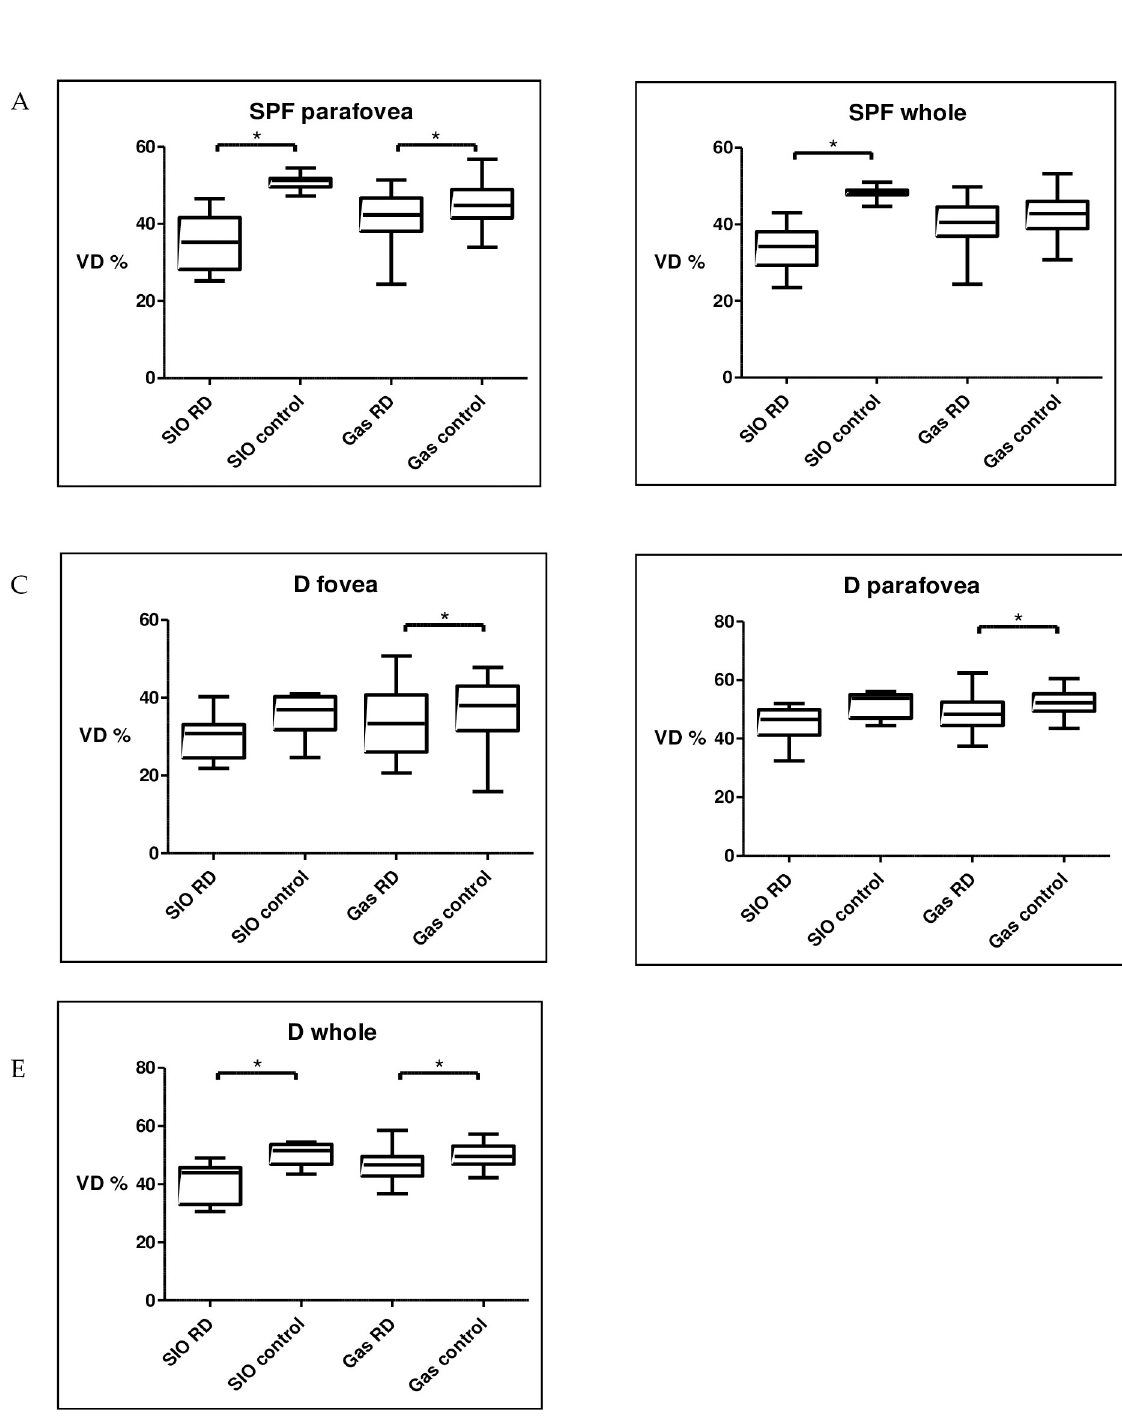
Fig 4. Significant differences in macula on-off subgroups. Superficial VD in parafovea (A.) and whole image (B.). C. Deep VD in whole image.